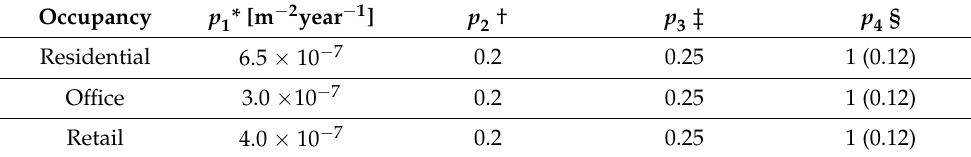
Table 7. Selected probability parameters in accordance with the NFSC Valorisation